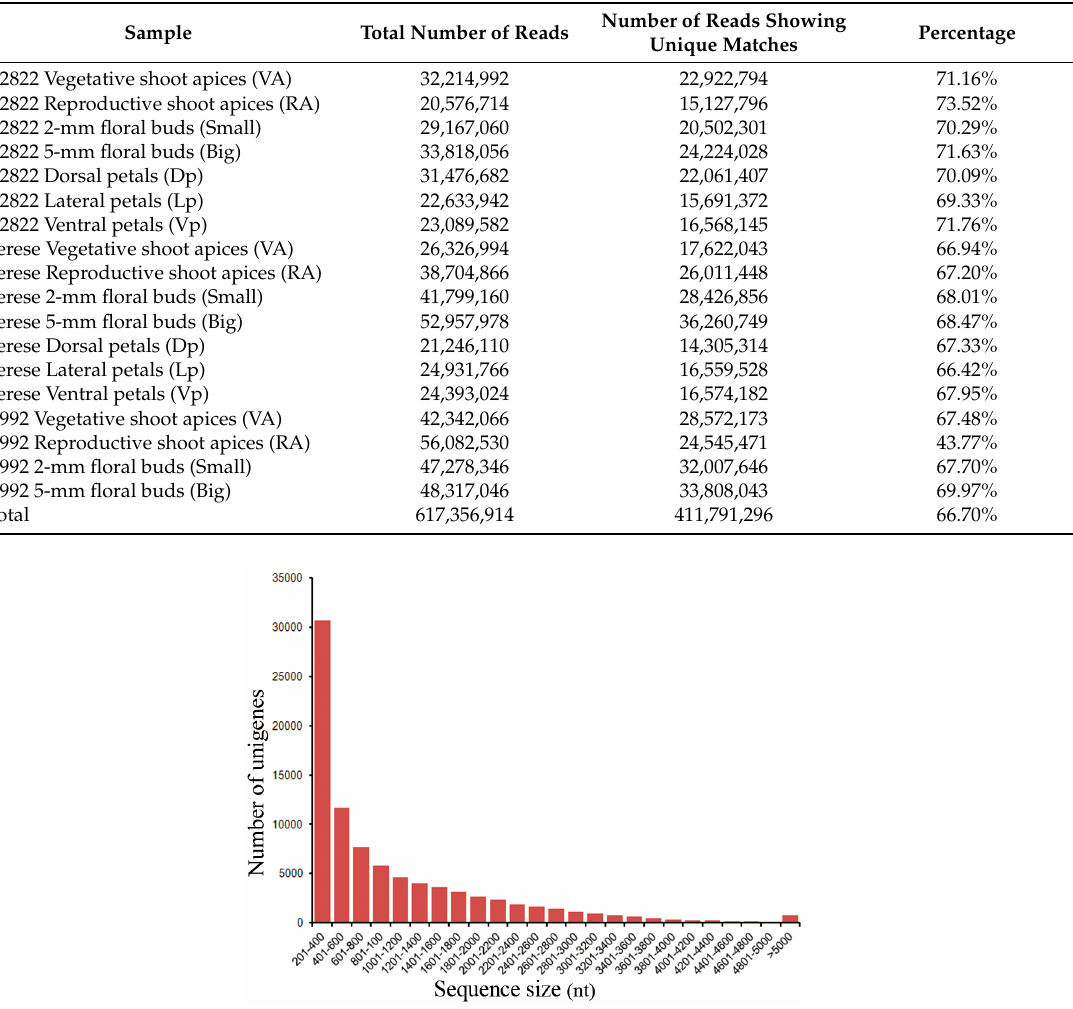
Table 1. RNAseq libraries analyzed in this study.